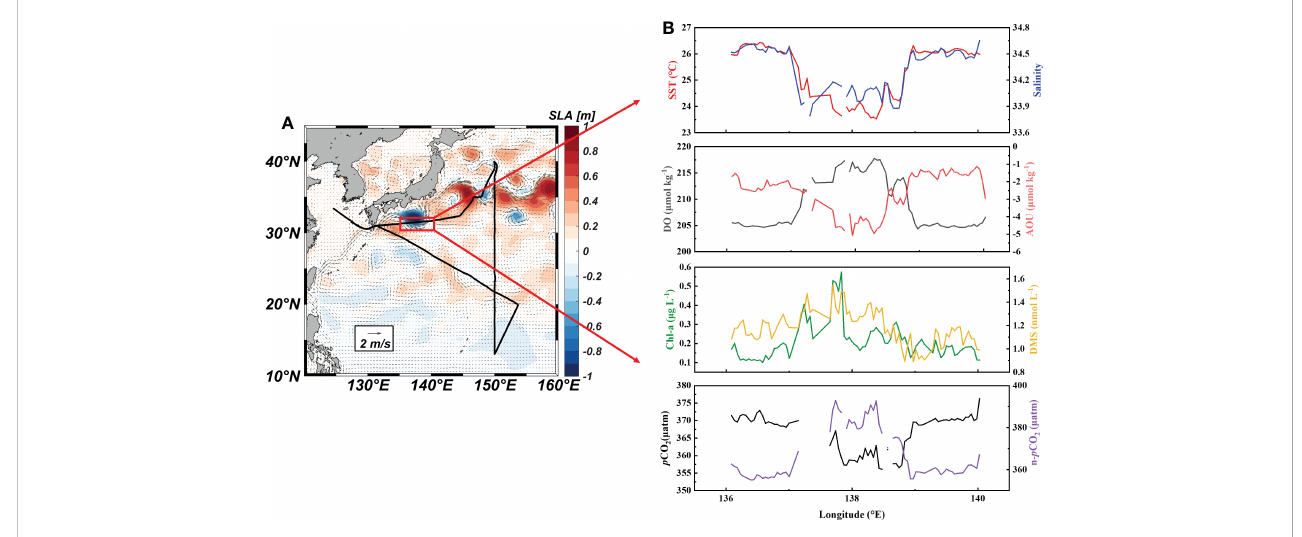
FIGURE 5 Monthly mean sea level anomaly and geostrophic currents in the Northwest Paci fi c Ocean (A) and underway parameters (SST, SSS, DO, AOU, Chl-a, DMS, p CO 2 and n- p CO 2 ) through the cold eddy (B)